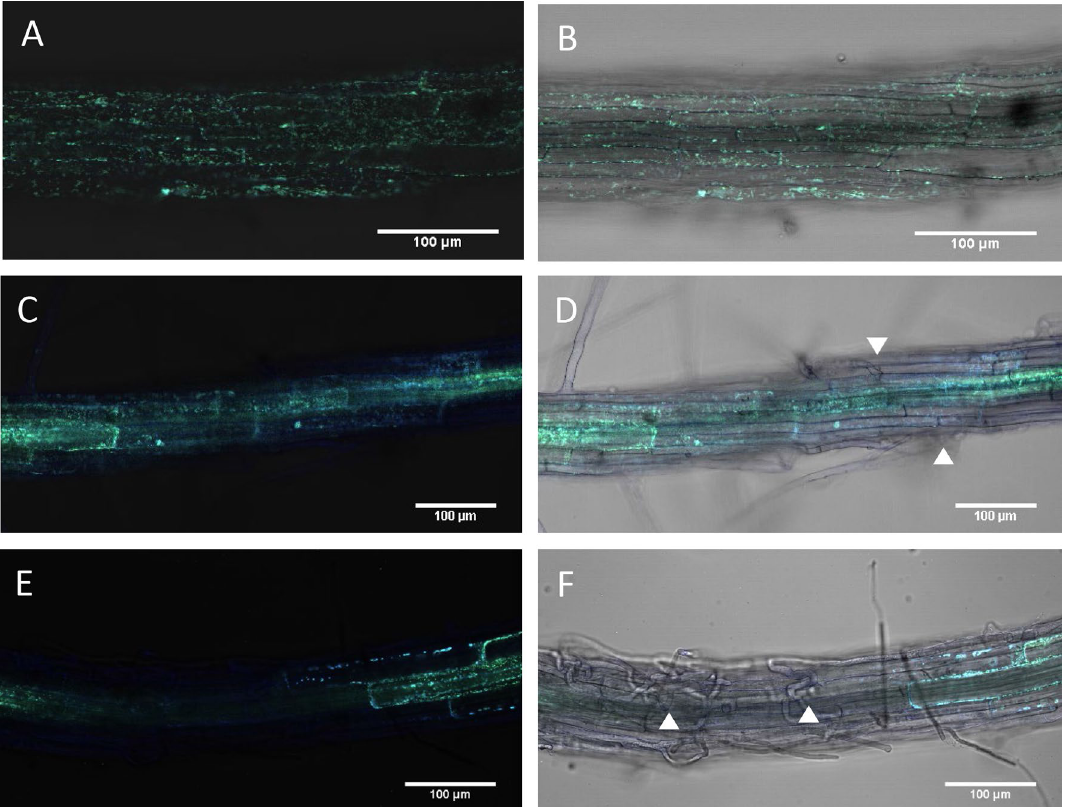
Figure 1. ( A , B ) Mock ( C , D ) AG2-1 and ( E , F ) AG8 infected mt-roGFP2 plants showing oxidation and loss of GFP expression in the epidermal and cortical cells after R. solani infection. Ratiometric confocal images were collected 48 h after infection or mock treatment and represent the ratio of fluorescence emission from excitation with the 405 nm (blue) and 488 nm (green) laser lines. Arrow heads represent infection sites. Scale bar represents 100 µm in all images. A minimum of 20 plants were imaged for each treatment and representative images were due to the death of those cells, (2) variation in the density of infecting hyphae observed along the same root, and 3) the inability to predict where on the root surface a successful infection would take place over 48 h precluded continuous live imaging collection to capture early penetration events prior to cell death occurring. Nonethe- less, infection with either AG8 or AG2-1 resulted in a loss of GFP expression in multiple cells surrounding the infection site suggesting both R. solani isolates induce the death of epidermal and cortex cells. We confirmed that the root cells that lost GFP fluorescence were undergoing cell death by staining AG8 and AG2-1 infected mt-roGFP2 roots with propidium iodide (PI). PI is occluded from the cytoplasm of healthy cells but is able to permeate the plasma membrane and stain nuclei during cell death 26 . Staining with PI showed that despite the striking differences in plant survival following infection with either AG8 or AG2-1, epidermal and cortex cells were indeed undergoing cell death in response to both AG8 and AG2-1 infection, while in uninfected mt-roGFP2 roots the majority of cells were viable and only a few root hair cells showed nuclear staining of PI (Fig. 2A-C). Infection of Arabidopsis roots with R. solani AG8 and AG2-1 results in a similar percentage of root death. As root infection with AG8 and AG2-1 appeared to result in cell death locally at the infection site, we hypothesized that AG2-1 might be more successful in colonizing the entire root system and therefore better resourced to colonize the above ground tissue. To examine this hypothesis, we quantified root cell death regions that showed a loss of GFP as a percentage of the total root length of AG8 and AG2-1 infected plants using PI staining over an infection time course. The root measurement software WinRhizo was used to measure PI stained and non-GFP expressing root regions versus GFP expressing roots. The percentage of surviving plants for each treatment was calculated per time-point before carefully staining and imaging the entire root system of each plant (Fig. 3A). At the 2 day time-point, AG8 and AG2-1 induced cell death was observed to be 15% and 12% of the total root length, respectively. The average root death percentage of AG8 and AG2-1 infected plants at 4dpi was also similar at less than 20% of the root length, despite approximately 50% of AG2-1 plants showing severe necrosis of the leaves at this stage (Fig. 3A-B, Supplementary Fig S4). AG2-1 plants that were completely necrotic at 4 dpi were measured by carefully teasing out the root systems from ver- miculite so as not to bias measurements with only the surviving plants. Leaf tissue with advanced necrosis did not withstand PI staining therefore, only the roots were quantified for cell death. Despite foliar necrosis, GFP